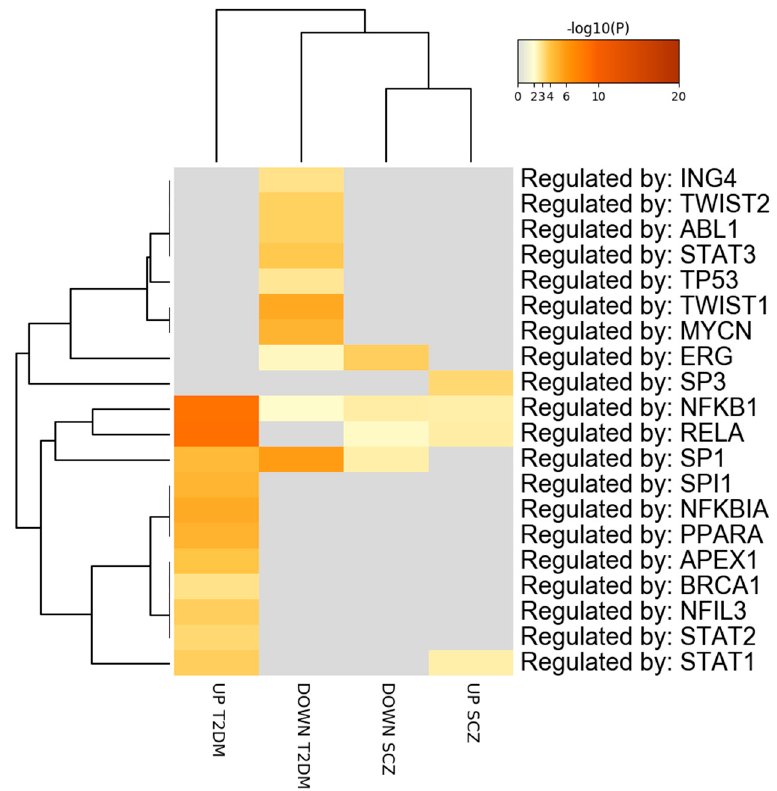
Figure 4. Putative transcription factors regulating the differentially expressed genes in peripheral blood mononuclear cells (PBMCs) from schizophrenia (SCZ) and type 2 diabetes mellitus (T2DM). The transcription factors are visualized as a hierarchical clustering. The heatmap is colored by the p -values, and gray cells indicate the lack of significant enrichment.